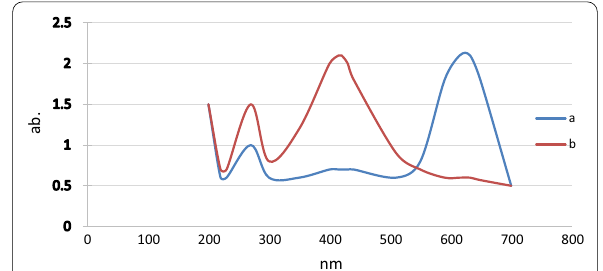
Fig. 1 UV-spectrophotometer diagram, UV absorption diagram, a PC, which had the highest UV absorption for PC at 620 nm, b AgNPs PC, which had maximum UV absorption for AgNPs PC at 420 nm